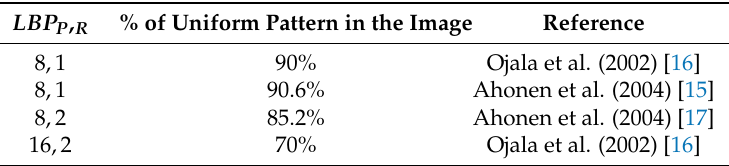
Table 2. Different LBP radius and neighbor values uniform pattern in the image.